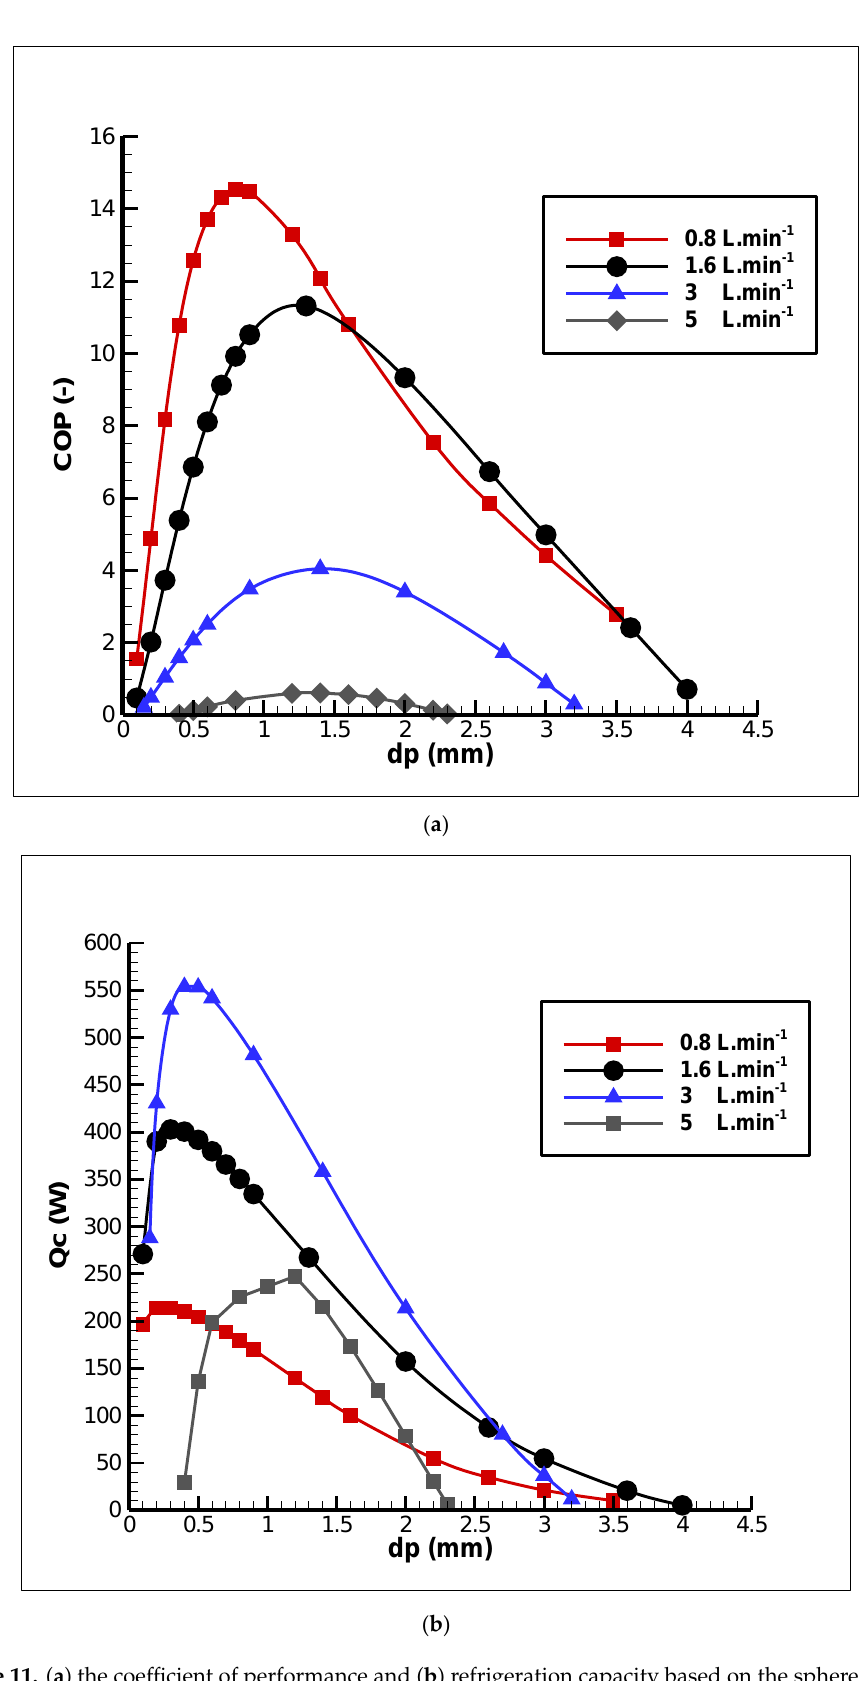
Figure 11. ( a ) the coe ffi cient of performance and ( b ) refrigeration capacity based on the sphere particle diameter for a temperature span of 1 K and a frequency of 4 Hz at di ff erent volumetric flow